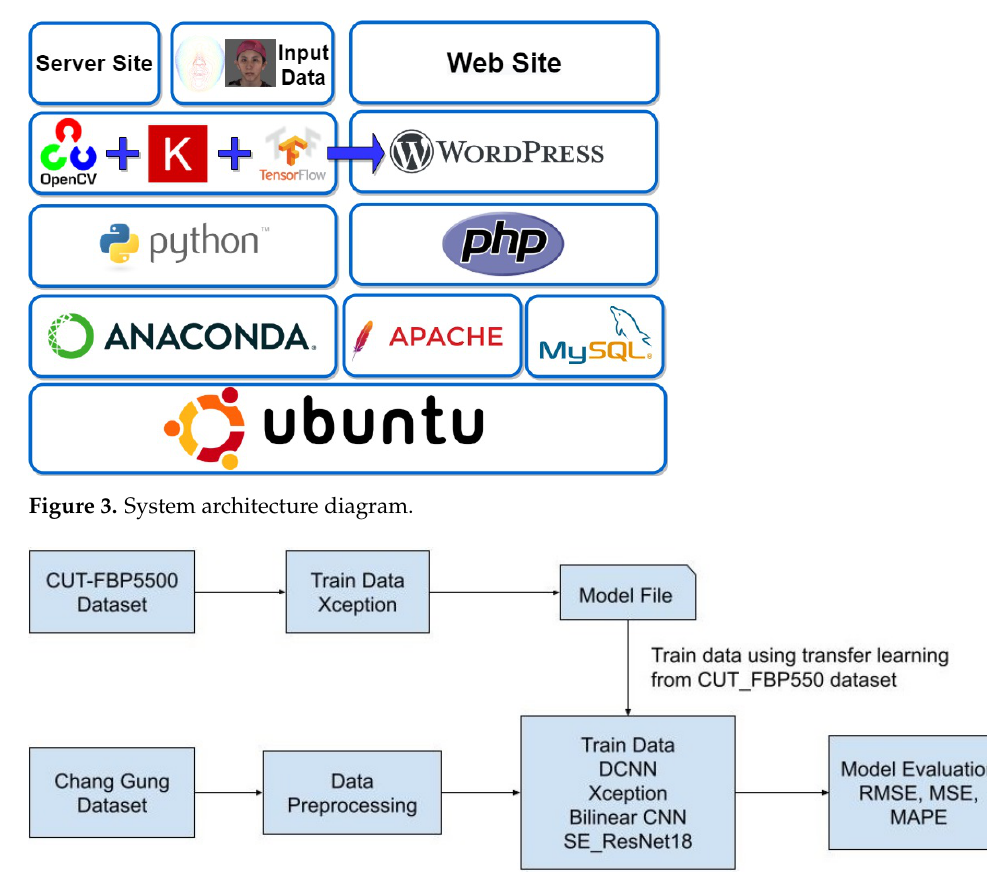
Figure 4. Workflows